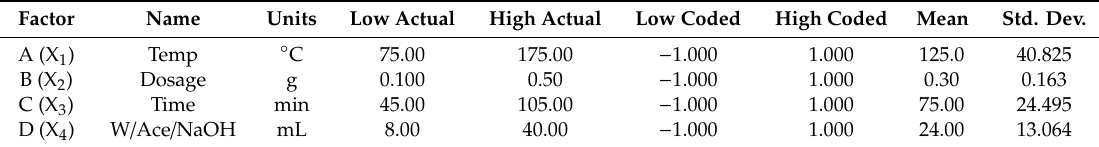
Table 1. Independent variables used in the Response Surface Methodology (RSM) design.